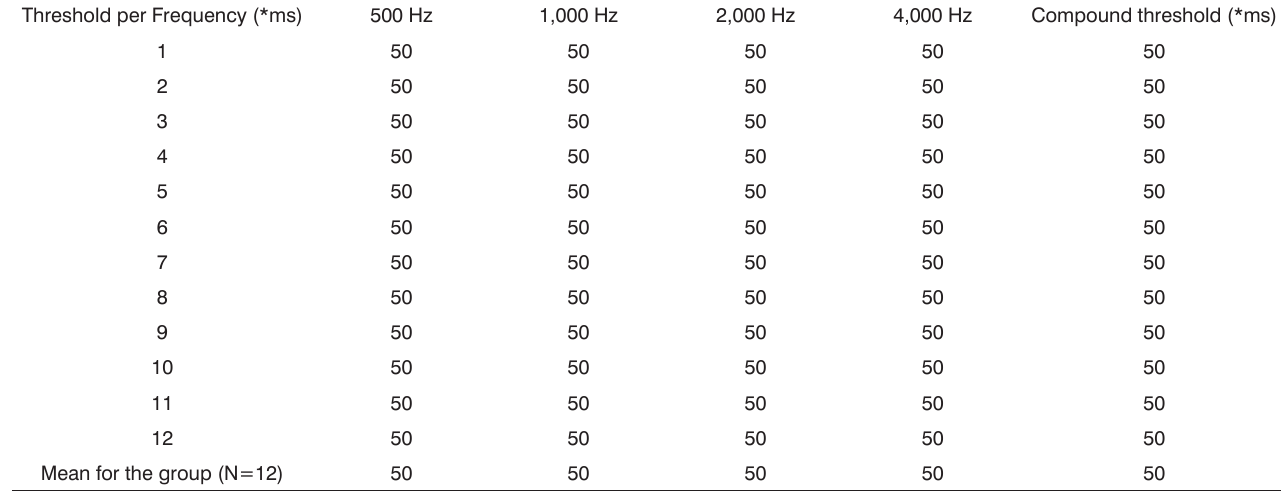
Frame 2. Analysis of random gap detection thresholds (extended) per frequency and compound thresholds (extended) for each participant, and the group mean - using the RDTG - E (N=12).